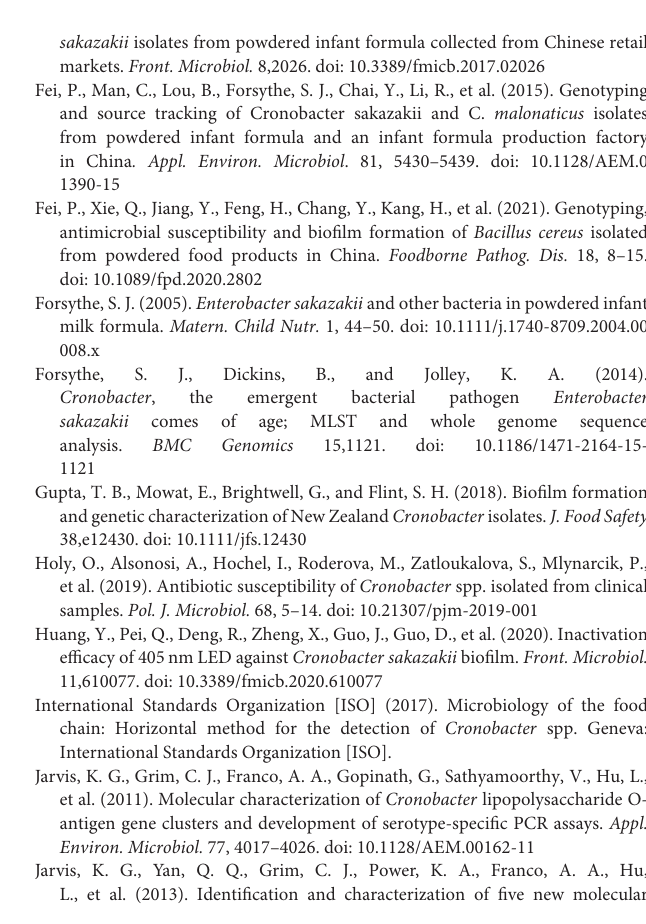
Supplementary Figure 1 | Sampling sites and milk source base of commercial PIF used in this study. Supplementary Table 1 | The specific information of all samples. Supplementary Table 2 | The sequences of 12 pairs of primers used for O-antigen serotype